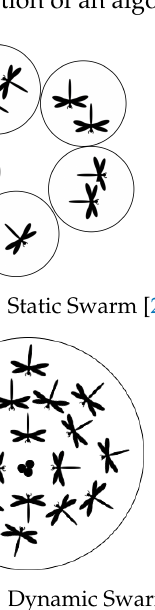
Figure 2. Dynamic Swarm